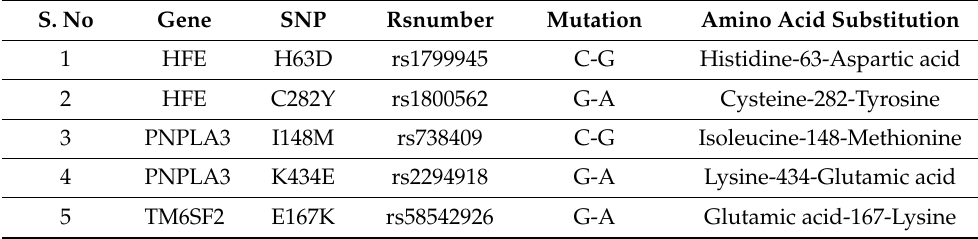
Table 1. SNPs in the NAFLD and non-NAFLD groups involved in this study. S.